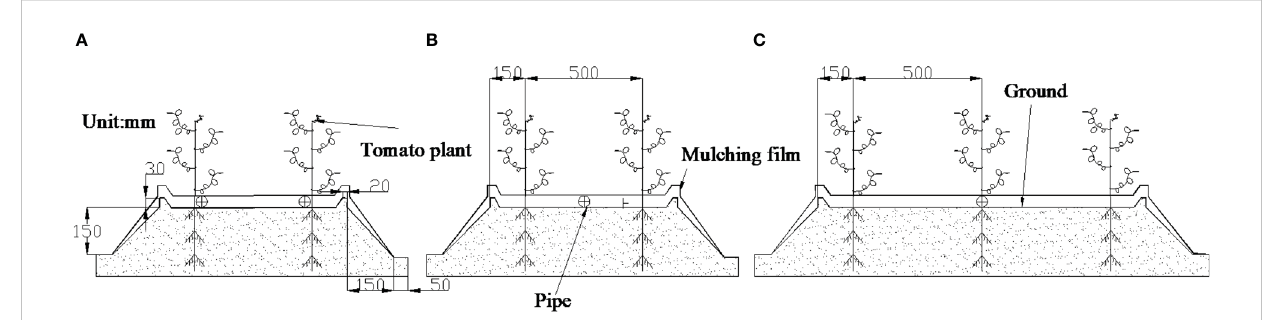
FIGURE 4 Capillary arrangement. (Zhang et al., 2020b). (A) represents one pipe for one row; (B) represents one pipe for two rows; (C) represents one pipe for three